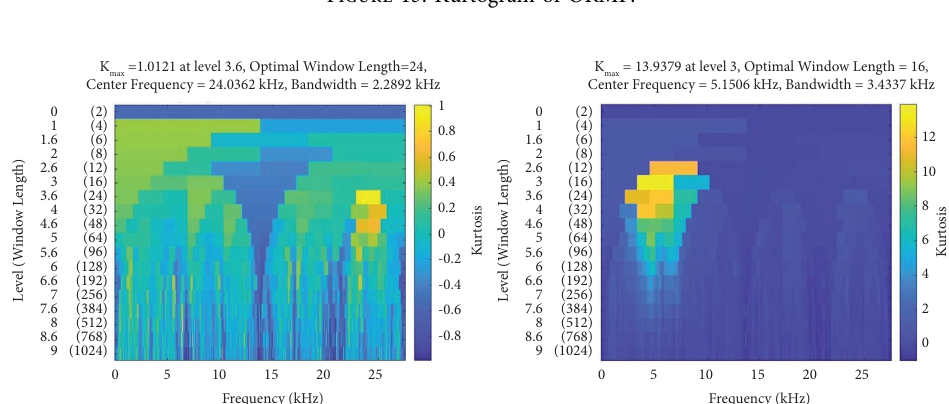
Figure 13: Kurtogram of ORMF.